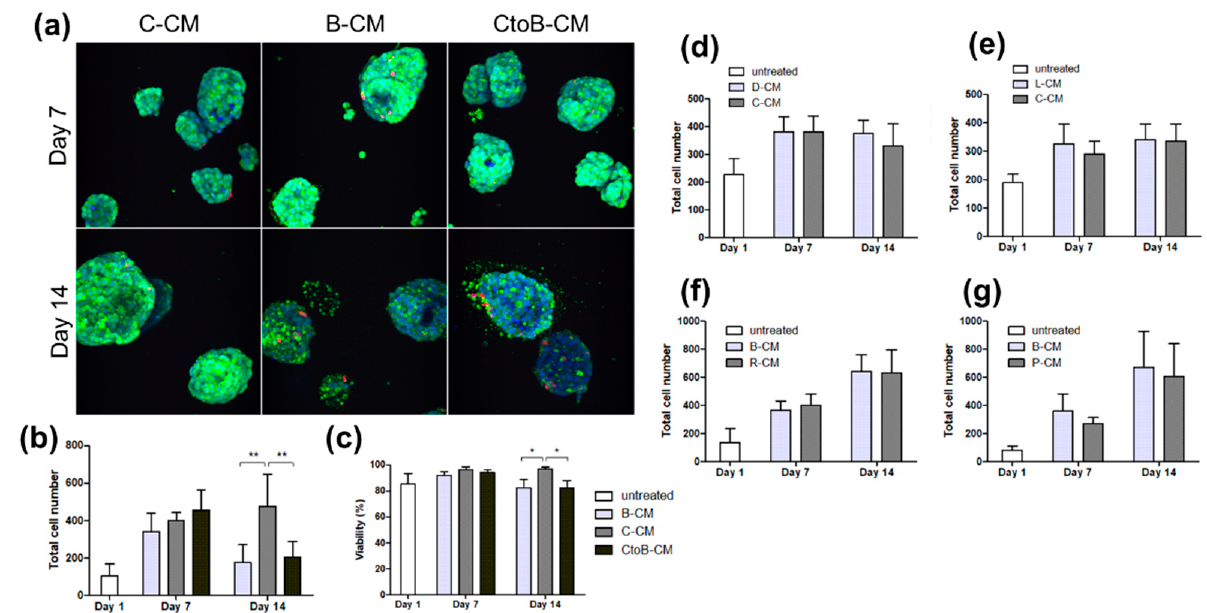
Figure 3. BMEC-conditioned media have a PCa-cell-type-specific effect on cell viability, not present in ECs of other tissues. Pre-clustered C4-2B cells were treated with BMEC-conditioned media (B-CM), C4-2B-conditioned media (C-CM), or conditioned media from BMEC cells that were treated with C4-2B-conditioned media (CtoB-CM). Cells were stained with calcein AM, ethidium homodimer, and Hoechst and imaged by confocal microscopy ( a ). IMARIS analysis of confocal z-stacks indicates a decrease in total cell number ( b ) and percent viability ( c ) on day 14 in conditions containing BMEC-conditioned media. Graphs represent means + SD. Statistical significance using two-way ANOVA with Bonferroni posttest, * p < 0.05, ** p < 0.01. Pre-clustered C4-2B cells were treated with HMEC-1-conditioned media (D-CM) or C4-2B-conditioned media (C-CM) ( d ) and HULEC-5a-conditioned media (L-CM) or C4-2B-conditioned media (C-CM) ( e ). Pre-clustered 22Rv1 ( f ) or PC3 ( g ) cells were treated with BMEC-conditioned media (B-CM) or the conditioned media from 22Rv1 (R-CM) or PC3 (P-CM), respectively.